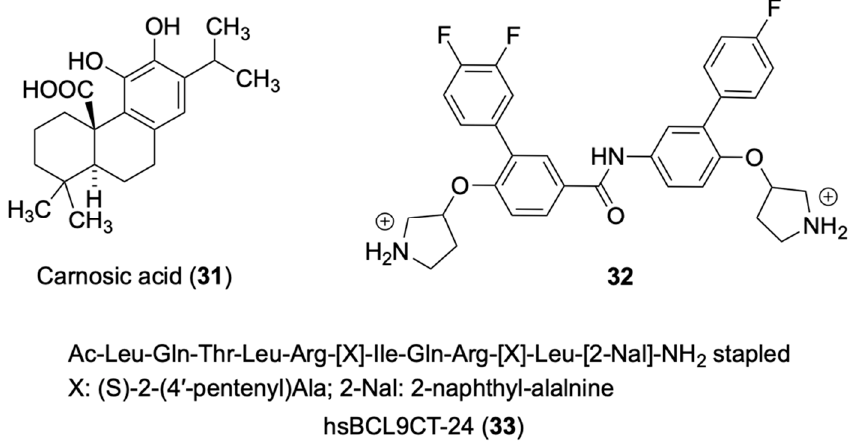
Figure 5. Chemical structures of compounds 31 – 33 inhibitors of β -catenin to BCL9.